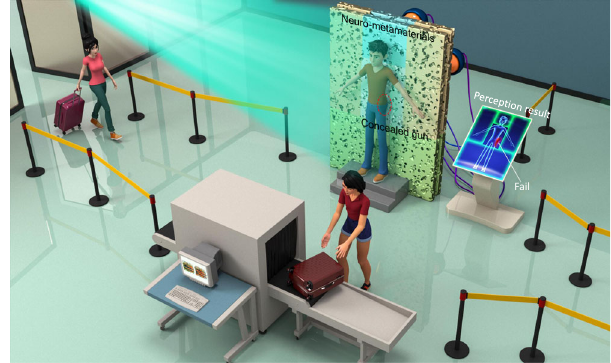
Fig. 1 Illustrative usage of neuro-metamaterials in a security inspection system. When a man goes through the security inspection system, he stands directly in front of a passive “ neuro- metamaterial wall ” fabricated from inhomogeneous metastructures. Under EM wave illumination, the wall performs the entire image processing and provides the result of the inspection in the form of an EM signal. Thus, the entire processing occurs without the need to convert the photonic to the (slower) electronic signal. In this example, to mitigate the complexity of designing the “ neuro- metamaterial wall, ” we deliberately divide it into several subregions represented by different colors, each of which is responsible for one speci fi c part of the human body. For example, a gun hidden at the waist will induce distinct scattered waves that will propagate and scatter further inside the wall and are translated directly to a warning signal at the customer interface. The fi gure was created by using Autodesk Maya and Photoshop